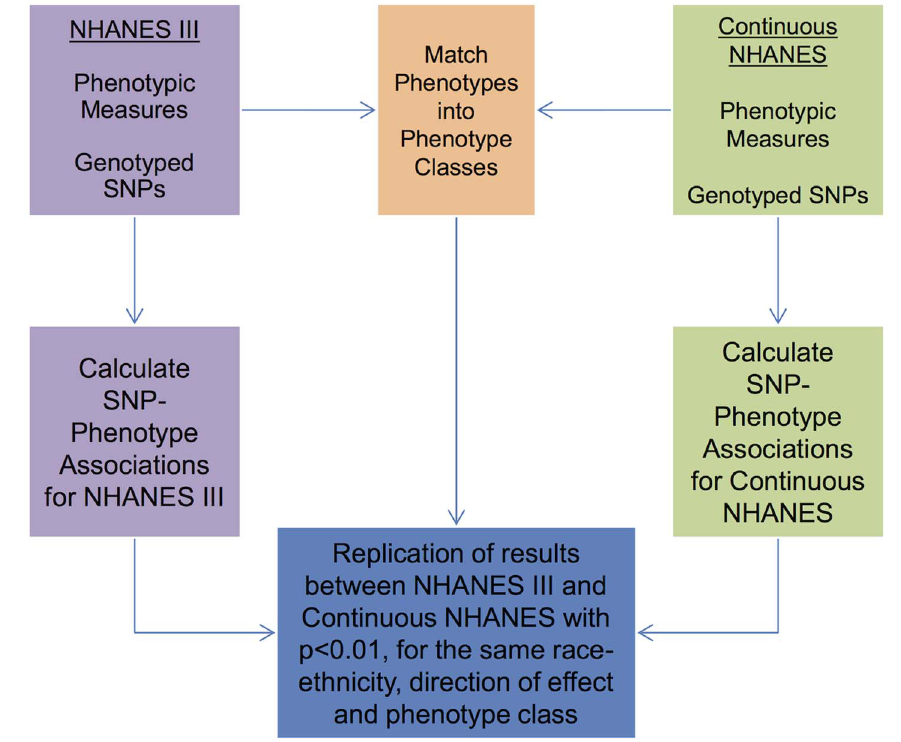
Fig. 1. Overview of the approach for this study. Genotypic and phenotypic data were collected in NHANES III and Continuous NHANES. The phenotypes for the two studies were matched into phenotype classes. Comprehensive associations were calculated for the genotypes and phenotypes for each survey independently. The results that were found in both surveys, with p , 0.01, for the same phenotype-class, and race- ethnicity, and same direction of effect, were maintained for further inspection in this study.